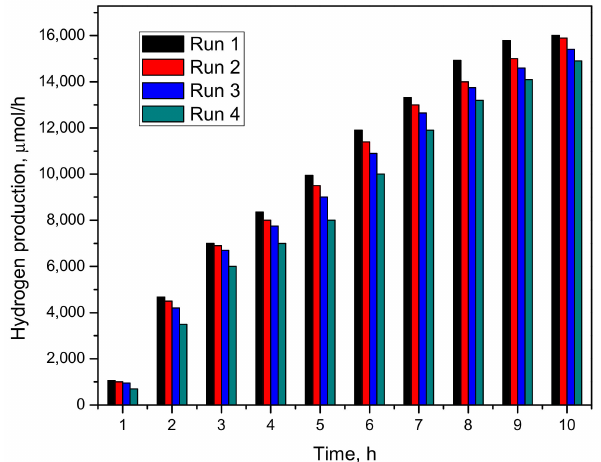
Figure 9. Photocatalytic activity of the TZr-10 sample in the generation of hydrogen from a methanol-water